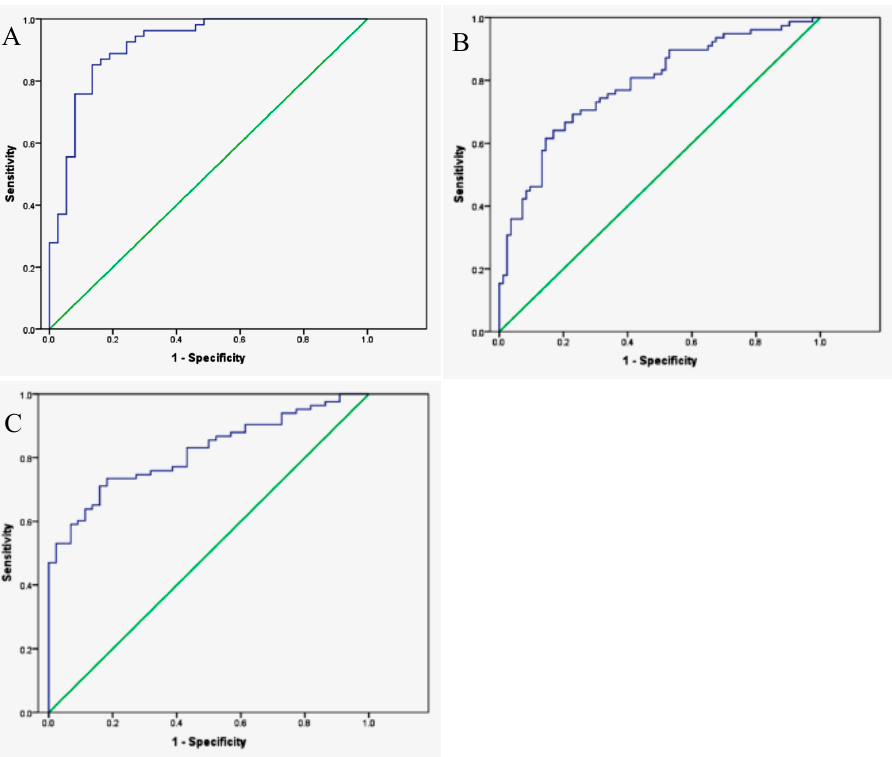
Figure 5. Receiver operating characteristic (ROC)-curves with 95% confidence intervals for diagnosis of ( A ) colorectal cancer (CRC) as compared with advanced adenomas; ( B ) CRC compared with controls; and ( C ) advanced adenomas when compared with controls. Used with permission from [49].